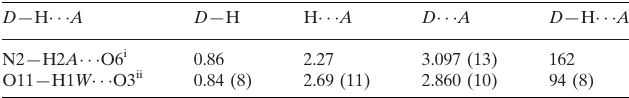
Hydrogen-bond geometry (A˚ , (cid:5)